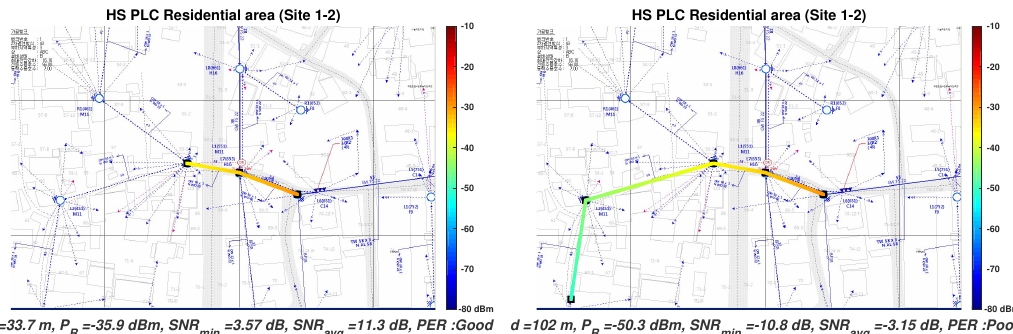
Figure 31. Graphical simulation of the received power for the HS PLC modem (Site 1-2, Overhead Residential Area). ( a ) MP at distance 33.5 m. ( b ) MP at distance 102 m.